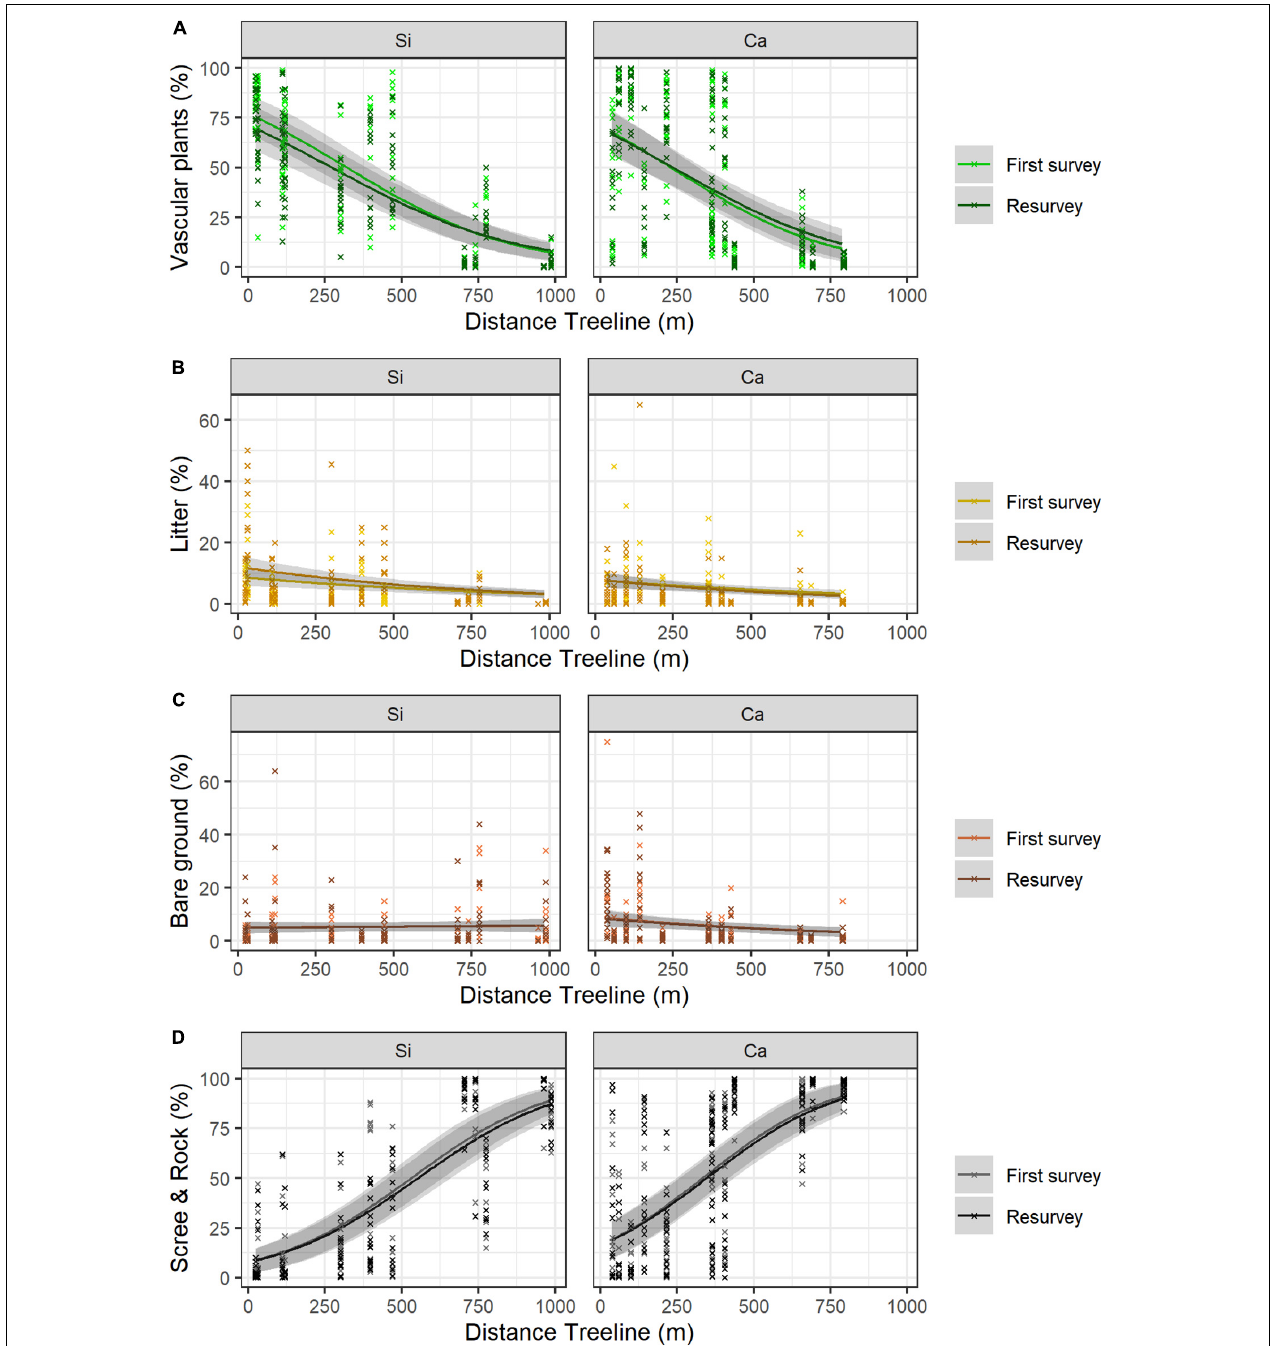
FIGURE 2 | Proportion of surface cover types (A) vascular plants (B) litter (C) bare ground and (D) scree & rock along the elevation gradient and changes over time (first survey vs resurvey) in siliceous (Si) versus calcareous regions (Ca). The lines show the predicted cover values with 95% confidence intervals (in grey) according to GLMMs. Mean values and standard errors were calculated across aspects and random regions. Crosses represent data. Values and significance levels of the effects are given in Table 2 .